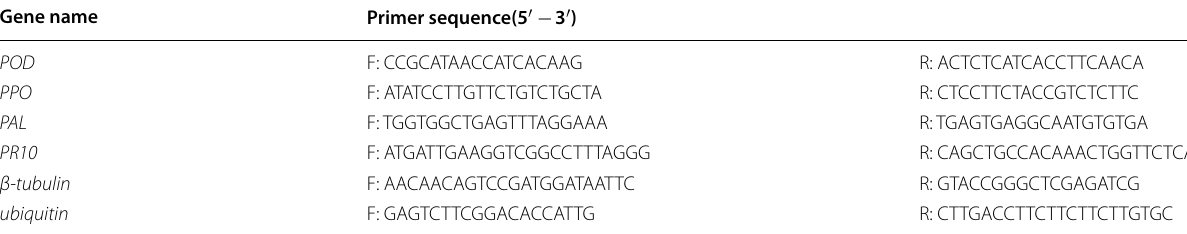
Table 1 Specific primers sequence of defense-related genes, the internal reference and β-tubulin Gene